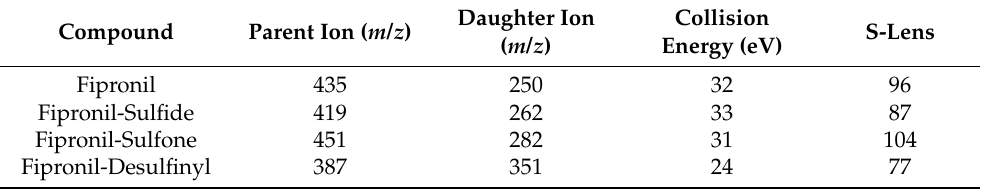
Table 7. Selected reaction monitoring (SRM) parameters at MS/MS